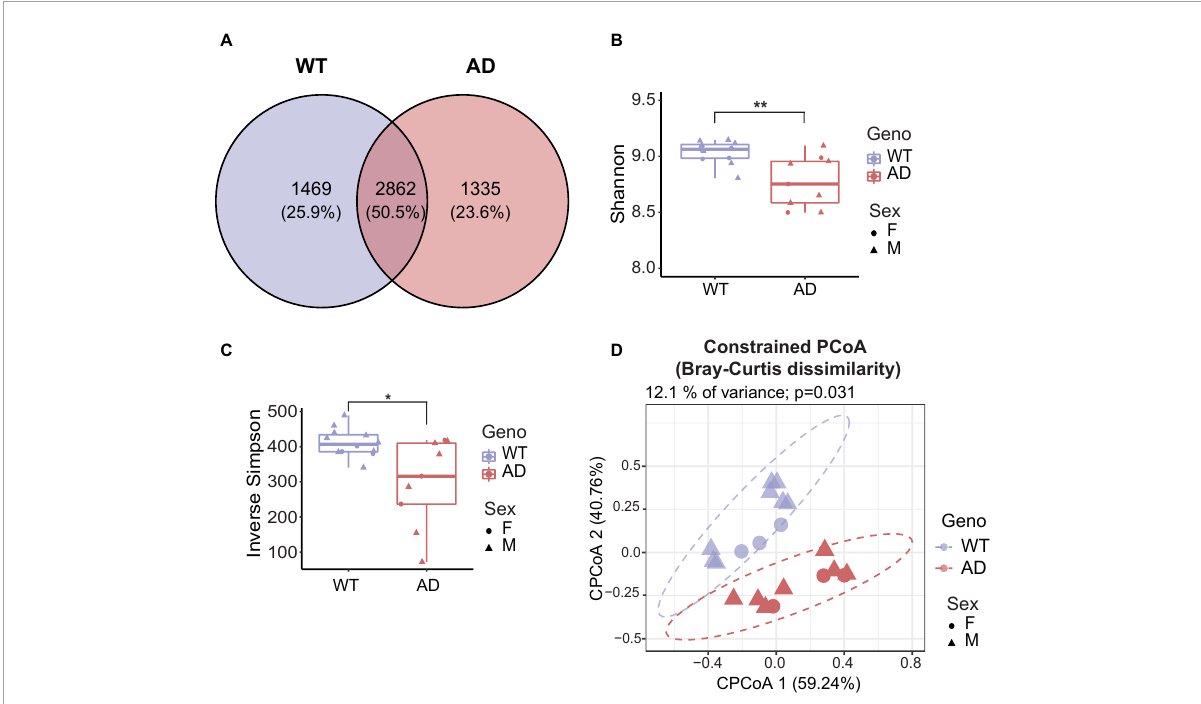
FIGURE1 Gut microbiota diversity decreased in Alzheimer’s disease (AD) mice. (A) Venn diagram showed the unique and shared operation taxonomic units (OTUs) between AD and wild-type (WT) mice. (B,C) Alpha diversity is represented by Shannon diversity (B) and inverse Simpson (C) indices. * P < 0.05, ** P < 0.01, Welch two-sample t -test. (D) Beta diversity is represented by constrained principal coordinate analysis (cPCoA) analysis using genotype as the constraining variable and ordinated with Bray–Curtis distances (12.1% of variance explained, P = 0.031). The percentage of variation indicated in each axis corresponds to the fraction of the total variance explained by the projection. Data are shown as all samples with a median value. F, females; M, males. * P < 0.05, ** P < 0.01, AD ( n = 9, 6 males and 3 females, 12-month-old) versus WT ( n = 11, 9 males and 3 females,